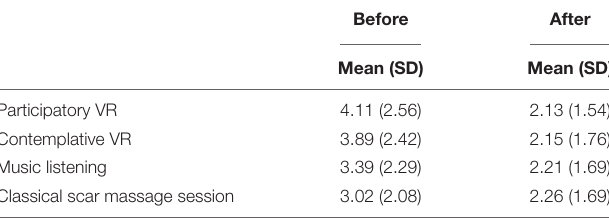
TABLE 5 | Means and standard deviation of emotional arousal by experimental condition as a function of the time of measurement.